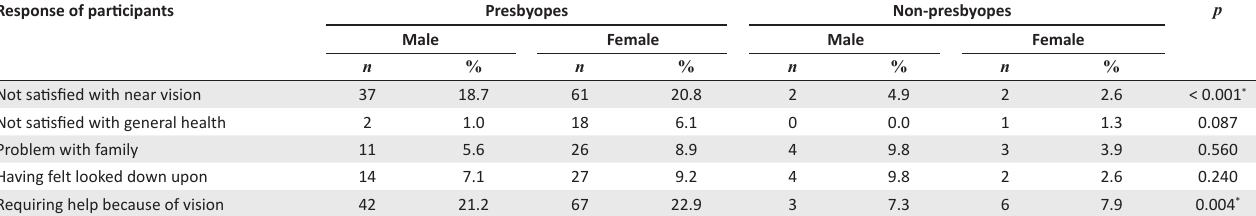
TABLE 6: Satisfaction with near vision and general health between presbyopes and non-presbyopes. Response of